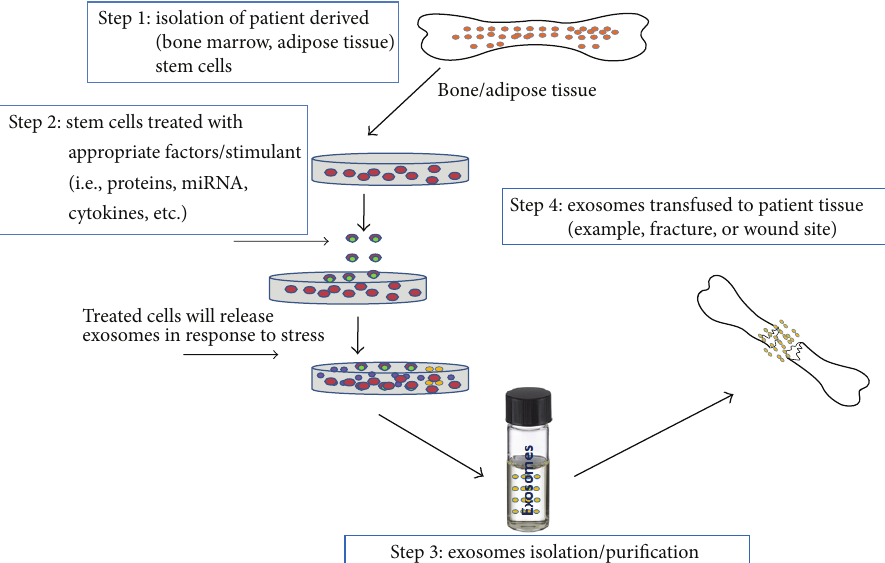
Figure 1: Schematic diagram of large scale exosome production and its use in tissue